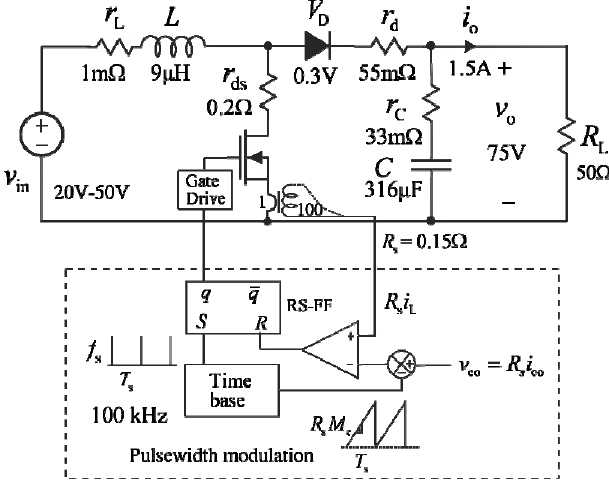
Figure 1. The power stage of the peak current-mode (PCM)-controlled boost converter in open loop with definitions of the component values and the operational conditions.